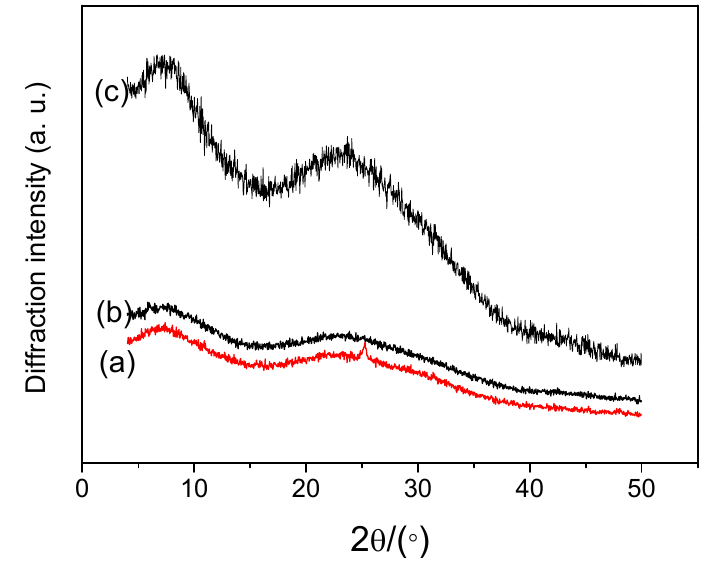
Figure 5. XRD patterns of CS-OA films (a) 0%; (b) 10%; (c) 25%